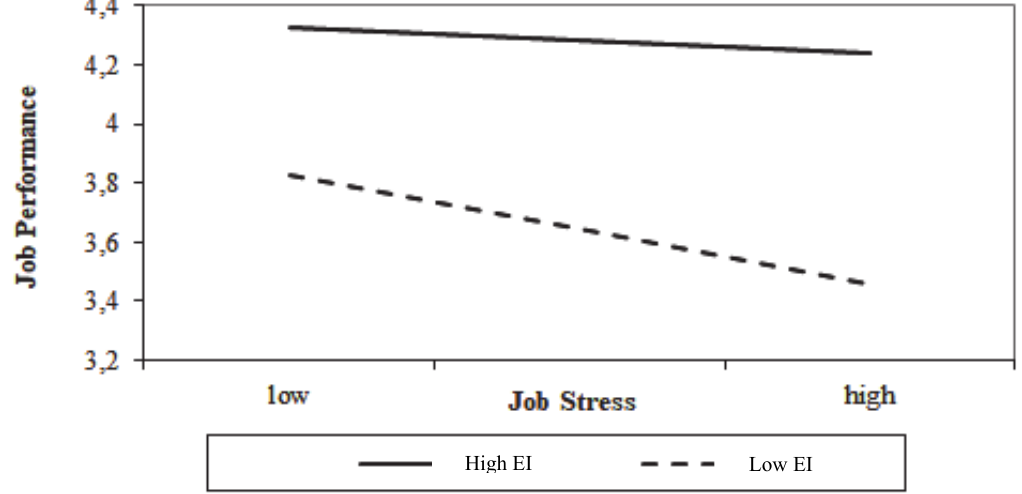
Fig. 2. Moderating effect of emotional intelligence (EI) on job stress - job performance relation